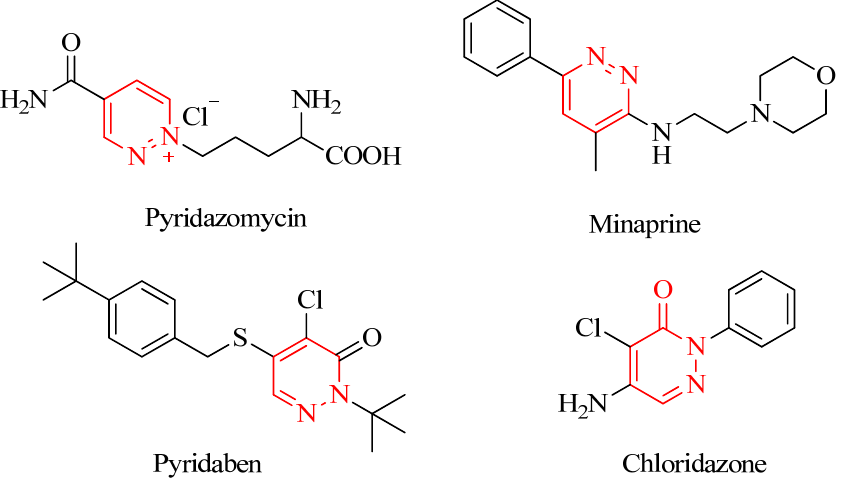
Figure 1. Chemical structures of biologically active Pyridazomycin, Minaprine, Pyridaben and